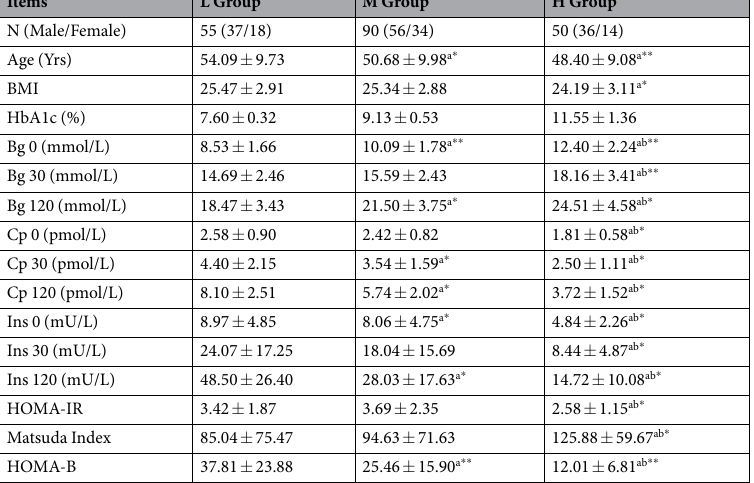
The patients were then divided into three groups according to HbA 1c values (L group with HbA 1c values ≤ 8%, M group with HbA 11.55 ± 1.36%, respectively. We observed that the BMI in the H group was significantly lower than that in the L group (24.19 ± 3.11 vs. 25.47 ± 2.91, P < 0.05). Moreover, patients in the H and M groups were younger than those in the L group (48.40 ± 9.08 vs. 54.09 ± 9.73, P < 0.01, 50.68 ± 9.98 vs. 54.09 ± 9.73, P < 0.05, respectively) (Table 1). Oral glucose tolerance test (OGTT) data showed that patients with higher HbA 1c values exhibited higher blood glucose concentrations and lower C-peptide and insulin levels at 0, 30, and 120 min after glucose load (Table 2). CGM data showed that 24-hr mean glucose concentrations (MG) (11.47 ± 2.19 vs. 9.46 ± 1.85 mmol/L, P < 0.01; 13.52 ± 2.20 vs. 9.46 ± 1.85 mmol/L, P < 0.01; 13.52 ± 2.20 vs. 11.47 ± 2.19 mmol/L, P < 0.01, respectively); the 24-hr standard deviation of the MG (SDMG) (2.55 ± 0.90 vs. 2.00 ± 0.79 mmol/L, P < 0.01; mean amplitude of glycemic excursions (MAGE) (6.30 ± 2.38 vs. 5.20 ± 2.35 mmol/L, P < 0.05; 7.44 ± 3.00 vs.